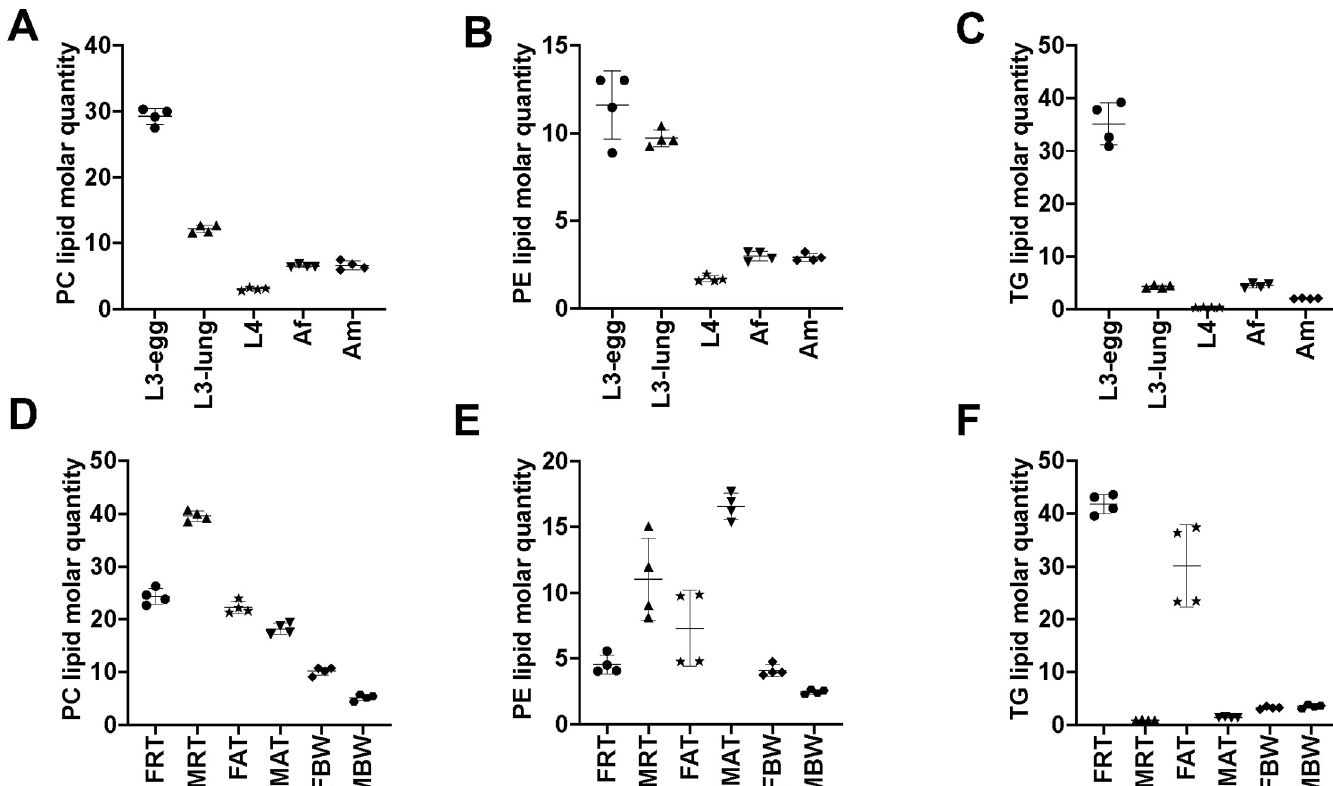
Fig 6. Quantitative differences in PC, PE and TG among developmental stages/sexes (A, B and C) and among adult organ systems (D, E and F) of Ascaris suum . The five developmental stages/sexes studied were: infective third-stage (L3-egg), lung stage L3 (L3-lung) and fourth-stage (L4) larvae; female (Af) and male adults (Am). The six adult organ systems studied were: the reproductive (FRT) and alimentary (FAT) tracts and body wall (FBW) of female adults; the reproductive (MRT) and alimentary (MAT) tracts and body wall (MBW) of male adults. Semi-quantitative analysis of lipid species, reported as the amount of lipid per mg of dry weight ( μ M/ mg). Statistical analysis was performed by ANOVA ( � P < 0.05). Error bars indicate ± SD (four